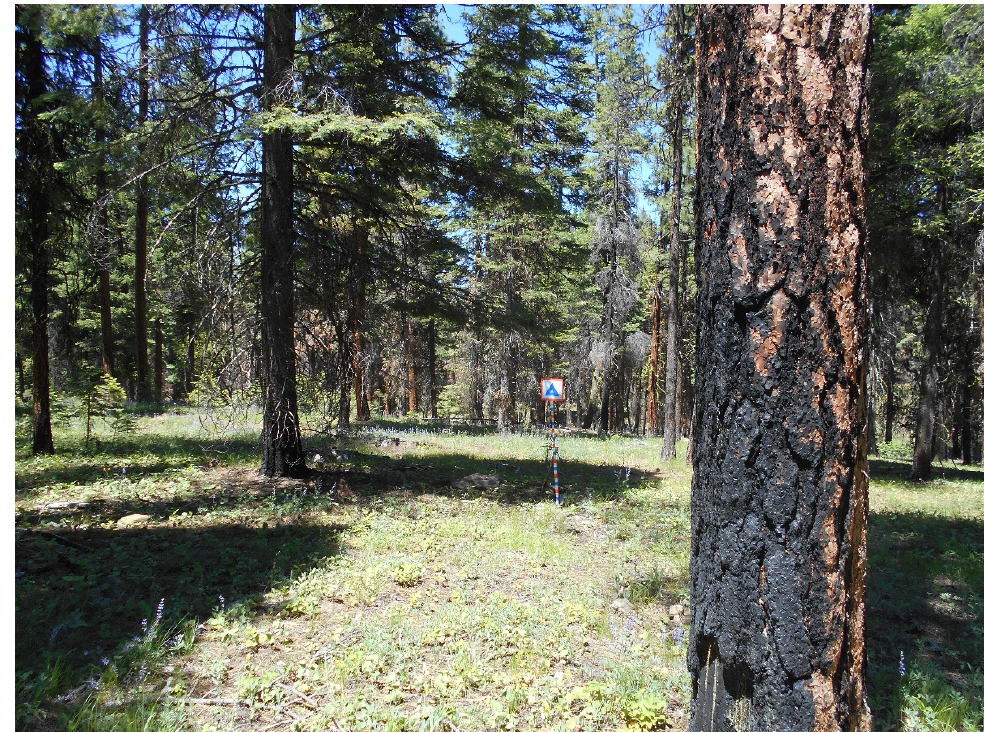
Figure 10. An example mixed-conifer burn-only treatment in eastern Oregon, USA. Residual surface fuels are minimal and CBH is consistent with scorch marks on the tree trunks, indicating a lift in CBH due to the prescribed burn.